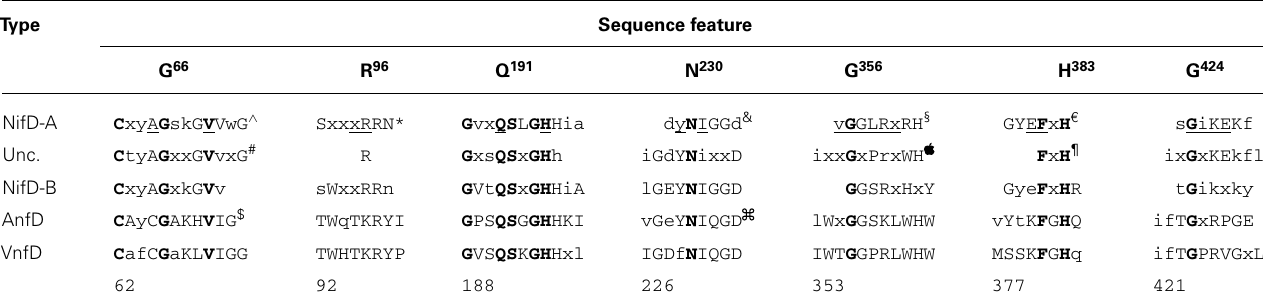
Table 2 | Sequence conservation near the nitrogenase active site.